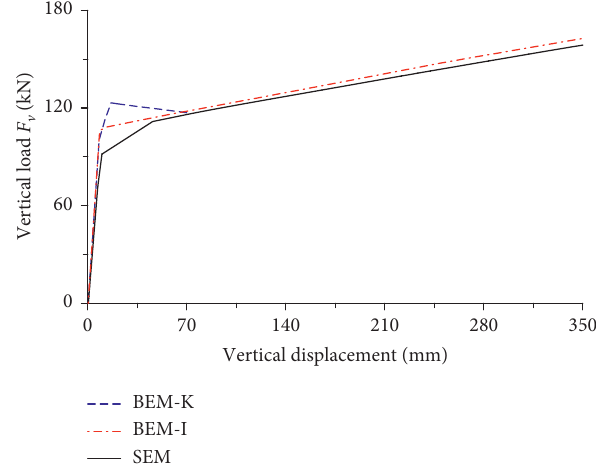
BEM-K BEM-I Figure 10: Load to vertical displacement curves of the BEM-K, BEM-I, and